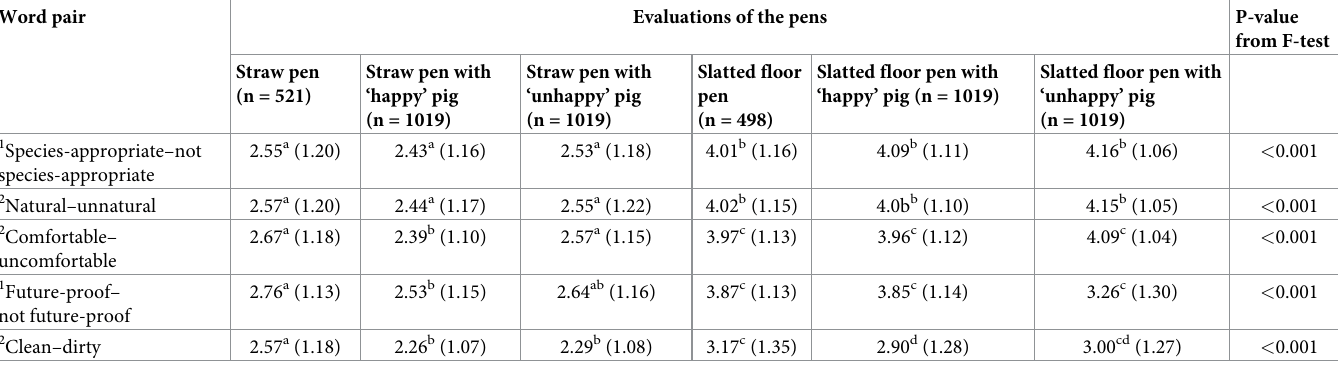
Table 5. Mean comparison using ANOVA and post-hoc tests for the evaluation of the straw and slatted floor pen presented separatly or with a pig (‘happy’/ ’unhappy’ pig). Word pair